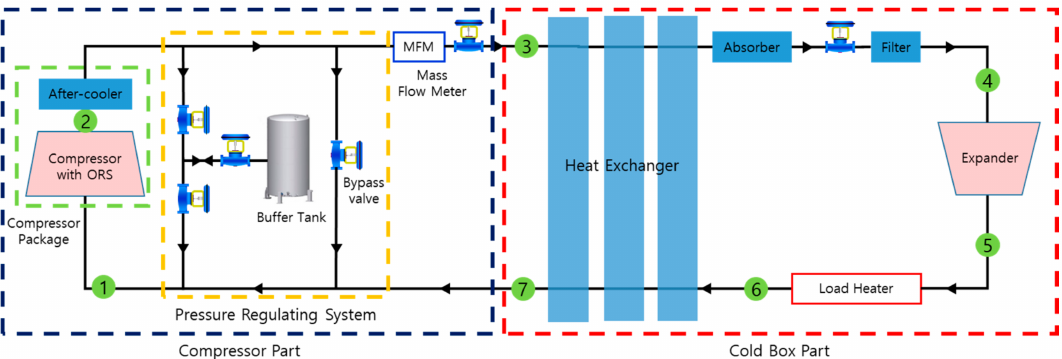
Figure 3. Schematicdiagram ofthe proposed reverse Brayton cryogenicsystem. ORS:oil removal system.